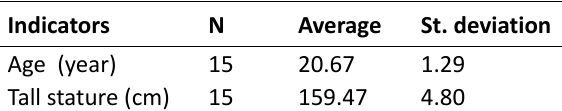
Table 2. Age and tall statures of the sedentary